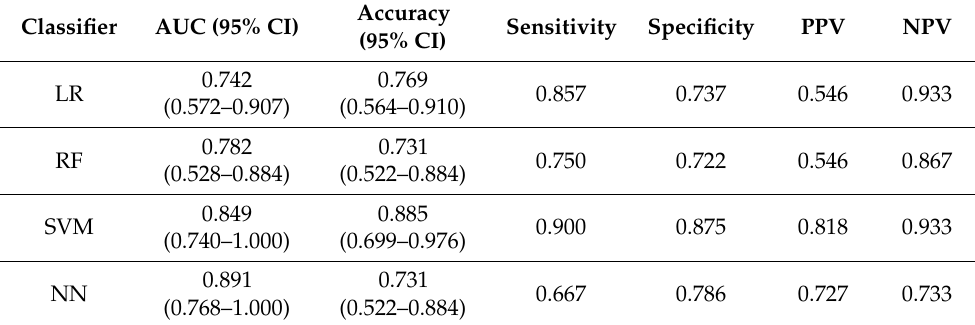
Table 3. Performance of machine learning classifiers for predicting tumor budding status in test dataset.